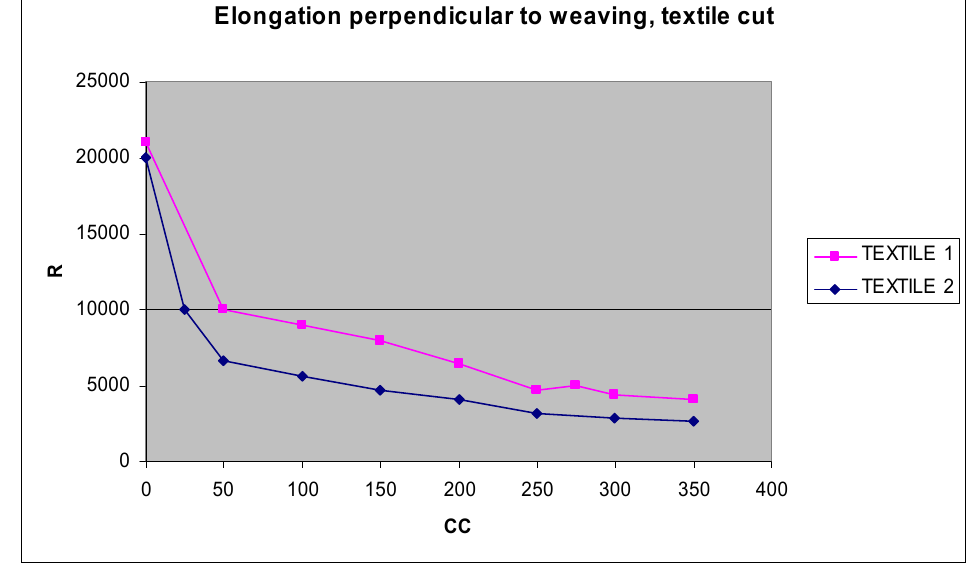
Figure 4. Graphic of the first test presented.